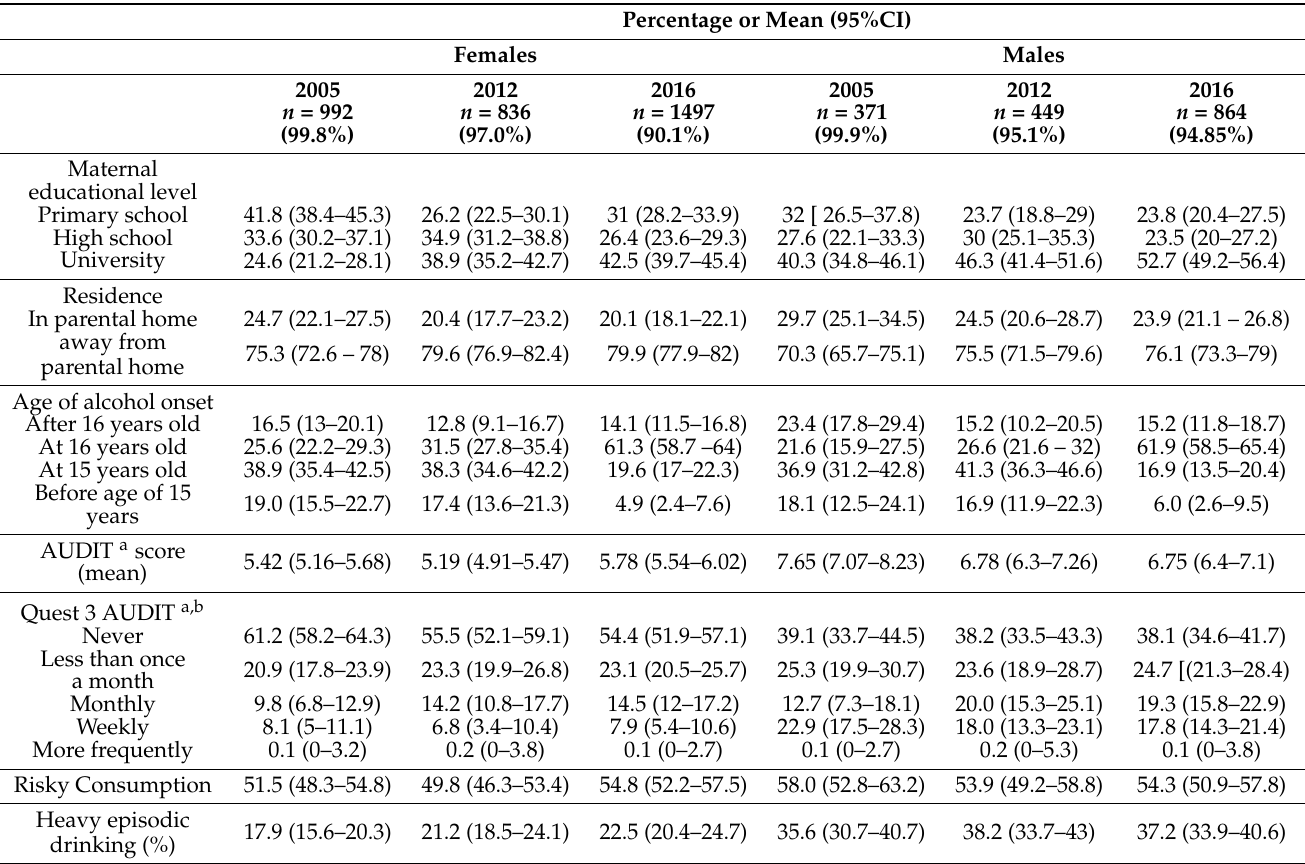
Table 1. Description of samples collected in 2005, 2012 and